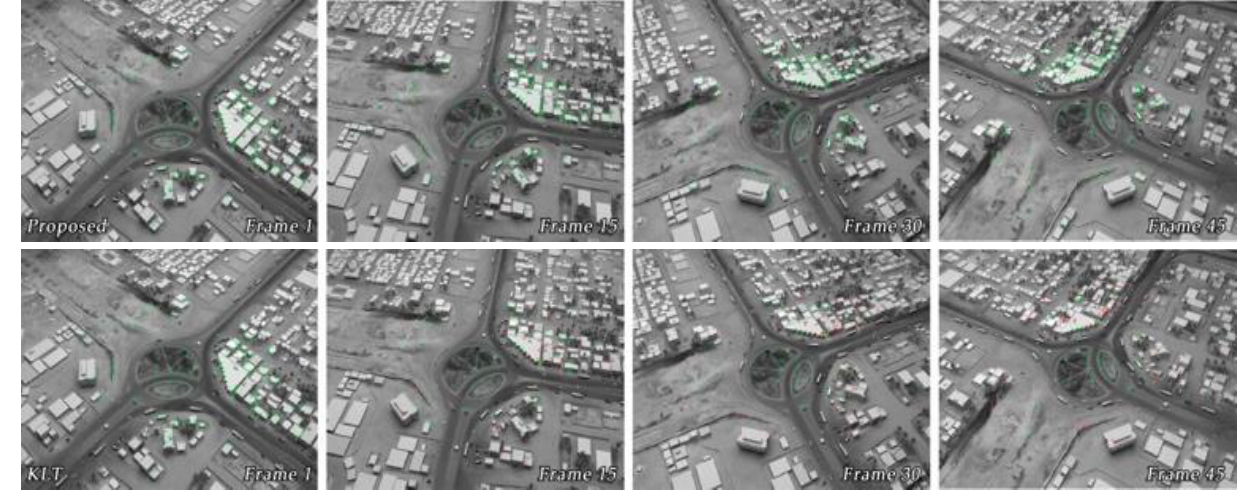
Figure 3. Tracking comparison between the proposed method (top) and KLT (bottom) shows a significant tracking improvement on this aerial dataset, especially along image borders where the camera perspective drastically skews feature appearance.